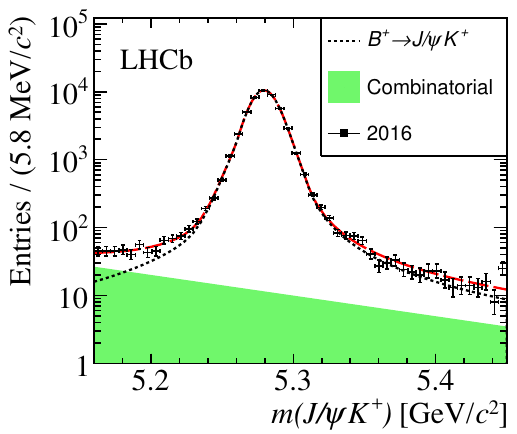
Figure 2 . Distribution of m ( J= K + ) with the (cid:12)t result shown for the 2016 data